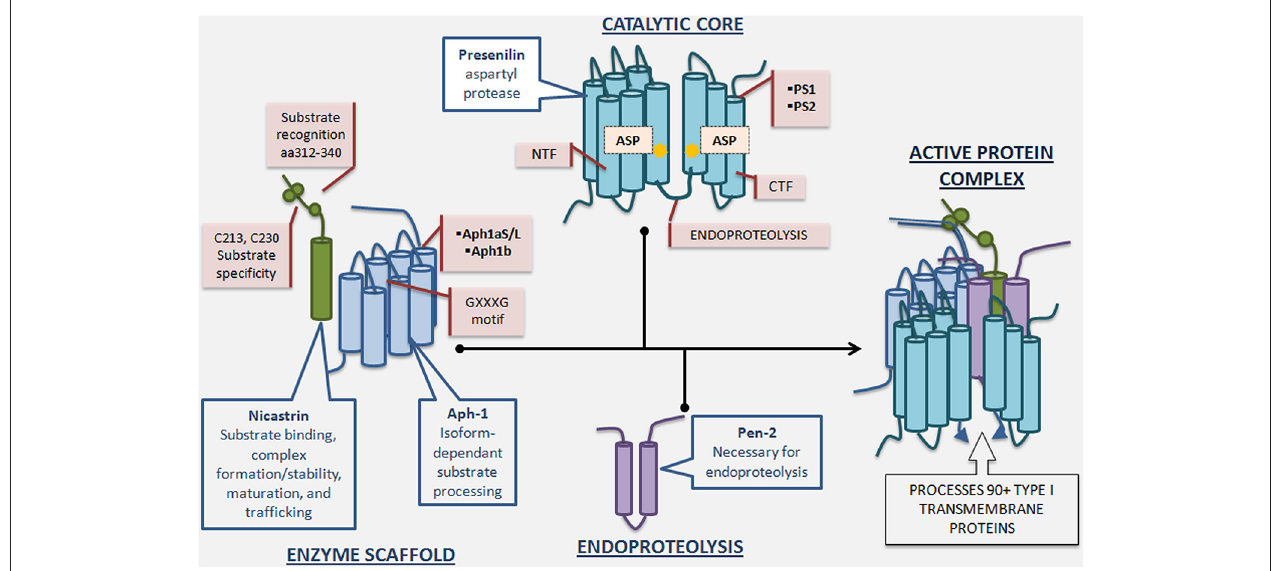
transmembrane protein with 3 human isoforms, is crucial for scaffolding and stability, and may have an additional role in determining length of A β species produced depending on which isoform is incorporated into the γ -secretase complex. The GXXXG motif in Aph-1 is critical for γ -secretase complex assembly. Presenilin, a 9-pass transmembrane protein with 2 isoforms, is the catalytic subunit of γ -secretase, and full length presenilin is a zymogen that must be endoproteolysed into NTF/CTF to be enzymatically active. Mutations in presenilin1 and presenilin2-encoding genes account for the majority of genetic mutations leading to Familial Alzheimer’s disease. Pen-2, a 2-pass transmembrane protein, is required for presenilin endoproteolysis and γ -secretase activation, but also may play an endoproteolysis-independent role in γ -secretase regulation. Active γ -secretase constitutes a small percentage of total γ -secretase and resides primarily in the plasma